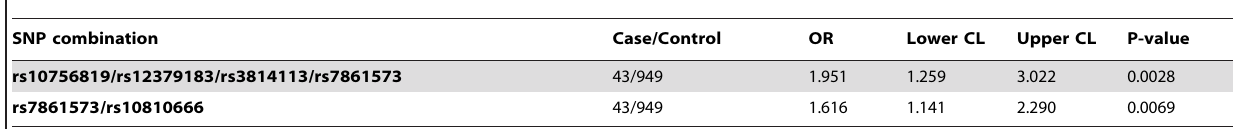
Table 3. Association of SNP combinations with abnormal TVU results.